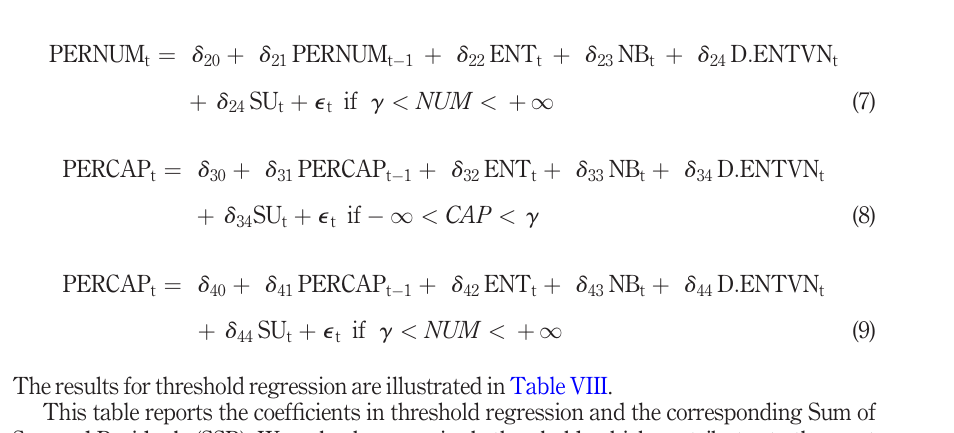
Table VII. Granger causality